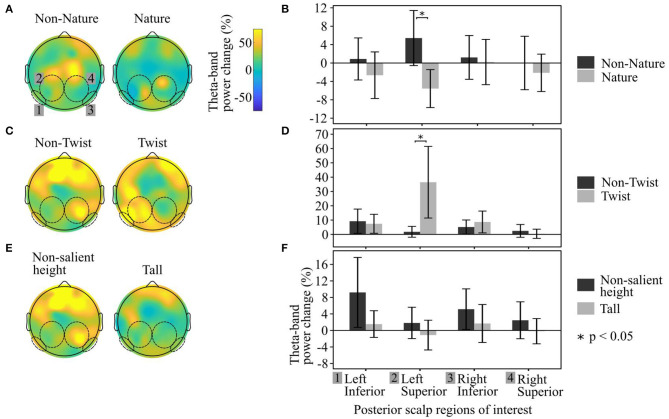
Grand Average Scalp Maps of theta (4.0–7.0 Hz) ERD/ERS when participants observed the buildings inside the VR environment. Comparison for (A,B) Non-Nature vs. Nature façade design buildings. (C–F) Relative building height. (A,C,D) Show the scalp map theta power change compared to baseline. (B,E,F) Numerical comparison of theta power change in the four posterior scalp regions of interest to each building condition [in the same left-right order as the scalp-maps in (A,C,D)]. Note different y-axis limits.